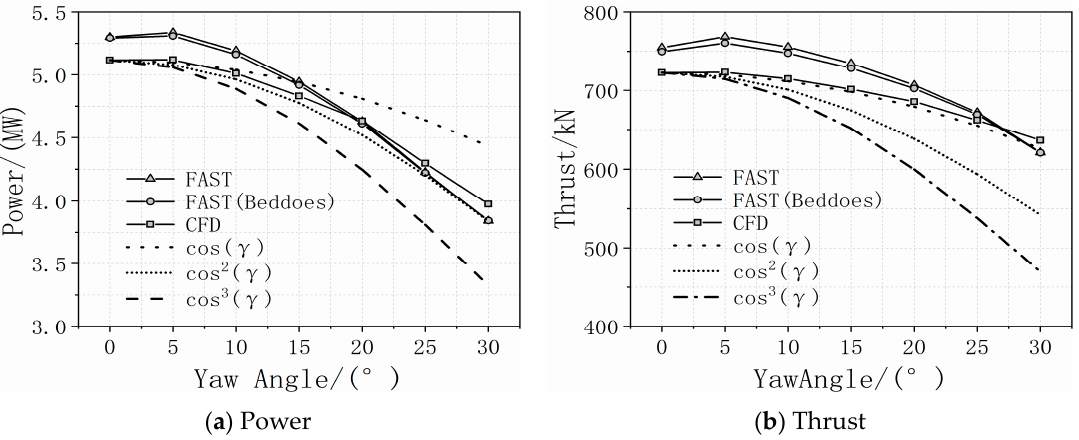
Figure 7. Variation of the power and thrust of the wind turbine under yaw.